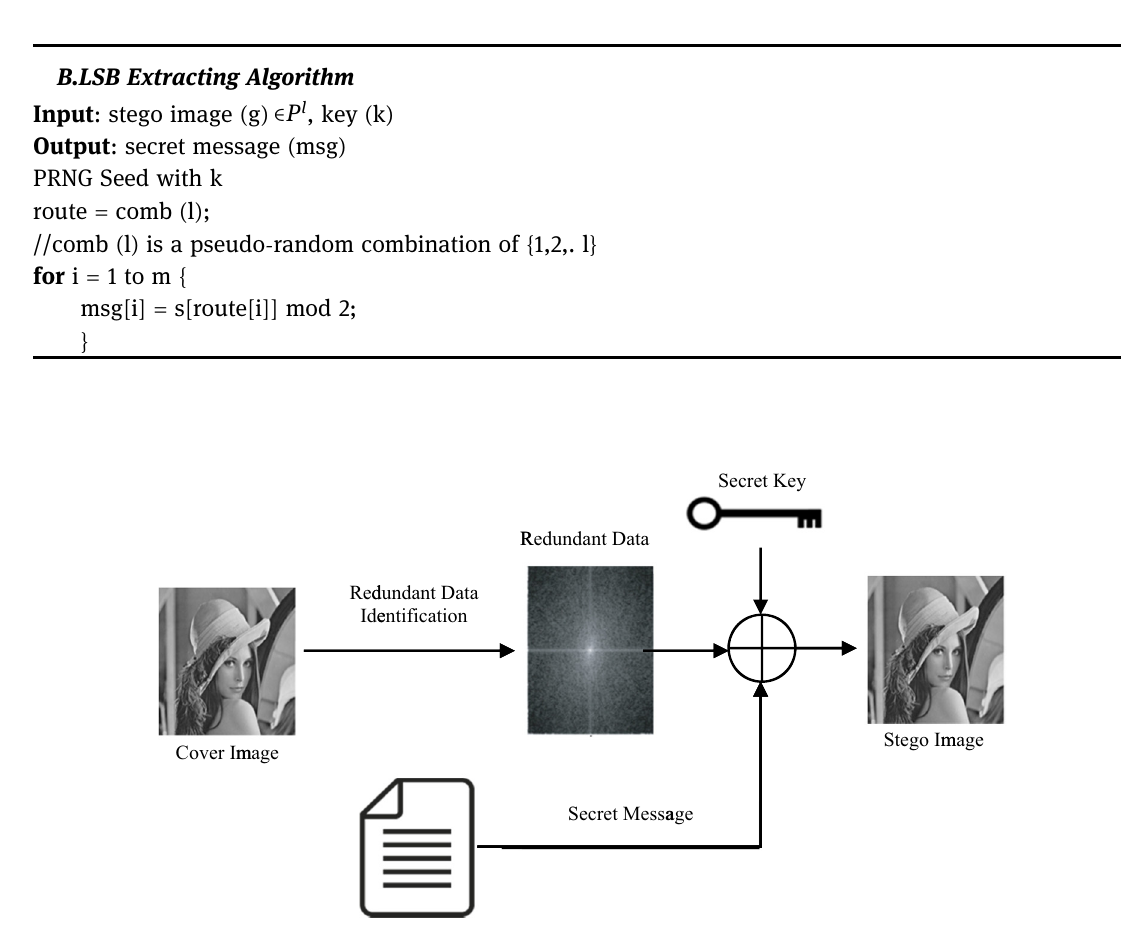
Figure 5: The embedding process for a con fi dential message into an image using the LSB